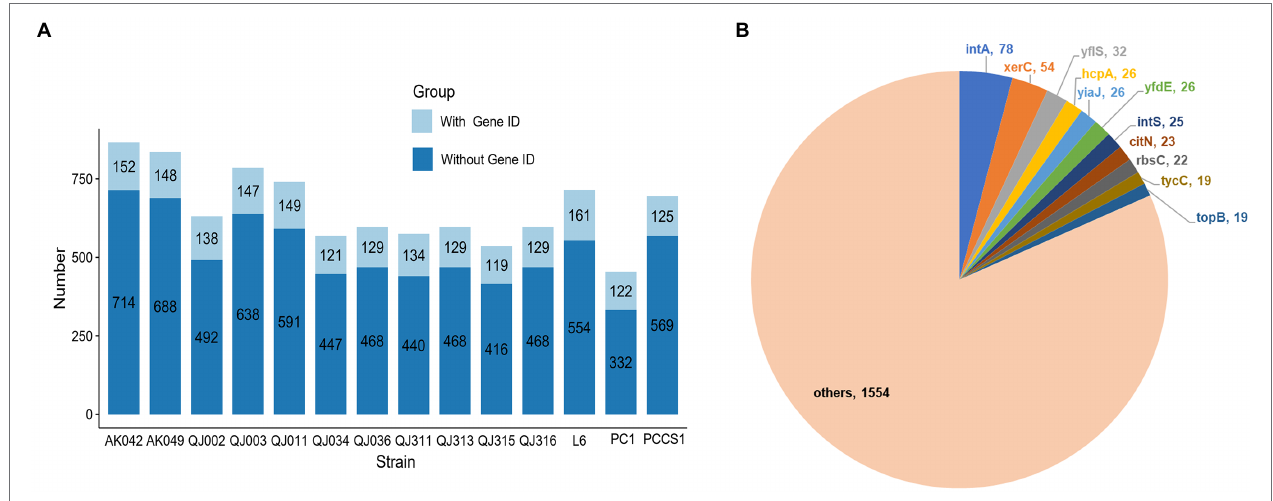
FIGURE 6 | Prediction of genomic islands (GIs) in 14 Pectobacterium aroidearum strains. (A) The bar plot shows the number of genes from GIs in each P . aroidearum strain. (B) The pie plot shows the frequency of top 11 genes. The values represent the total occurrence number of each gene in 14 P . aroidearum